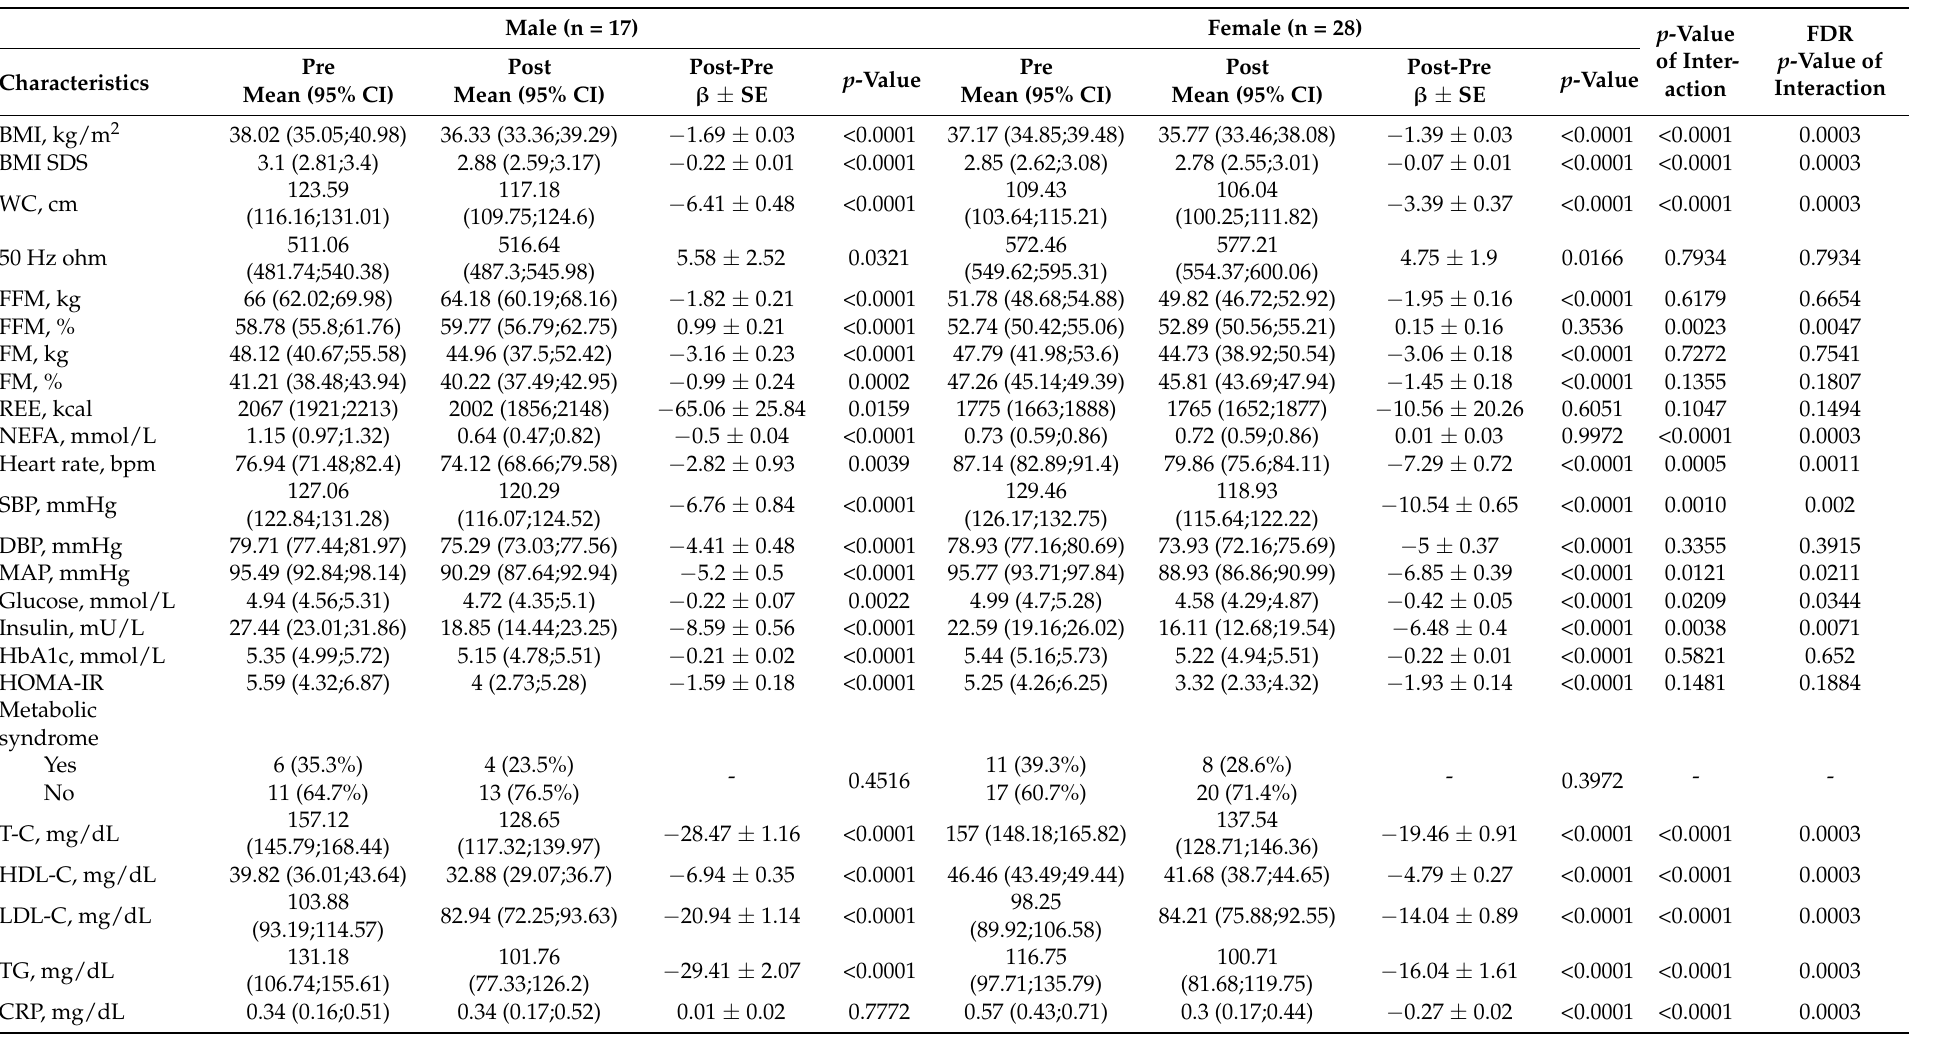
Table 3. Demographic, lifestyle, biochemical and clinical characteristics of study participants: pre- vs. post-BWRP comparison in males and